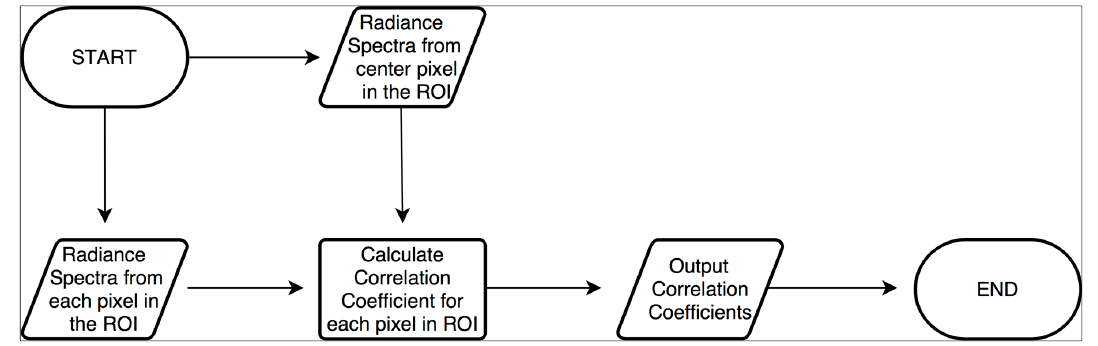
Figure 6. Schematic view of the basic algorithm for the application of the CC in the spatial localization of errors in HSI data.